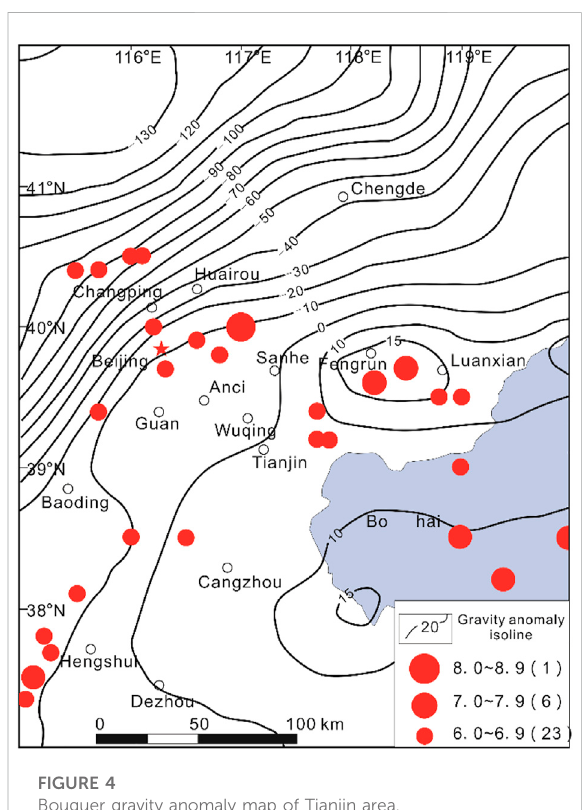
FIGURE 4 Bouguer gravity anomaly map of Tianjin area.